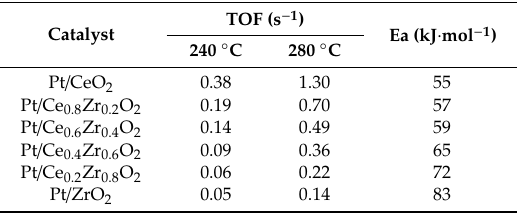
Table 5. Turnover frequency (TOF) and activation energy (Ea) for WGS reaction over Pt/CeO 2 , PtZrO 2 and Pt/Ce (1-x) Zr x O 2 catalysts, date from [82]; at P = 1 atm, 6.5% CO, 7.1% CO 2 , 0.7% CH 4 , 42.4% H 2 ,